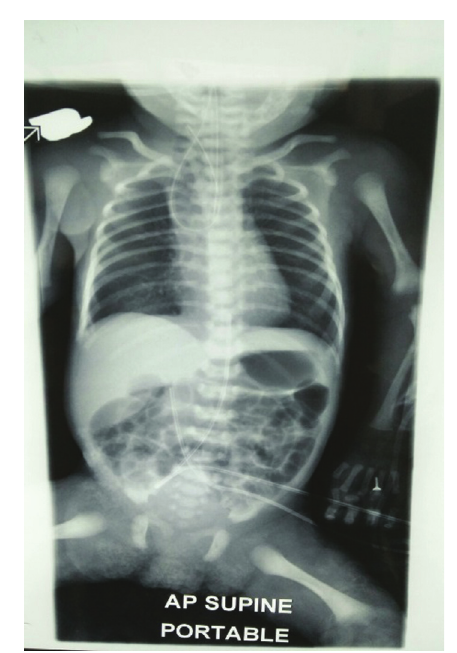
A chest and abdominal radiograph of the child with coiled Ryle ’ s tube